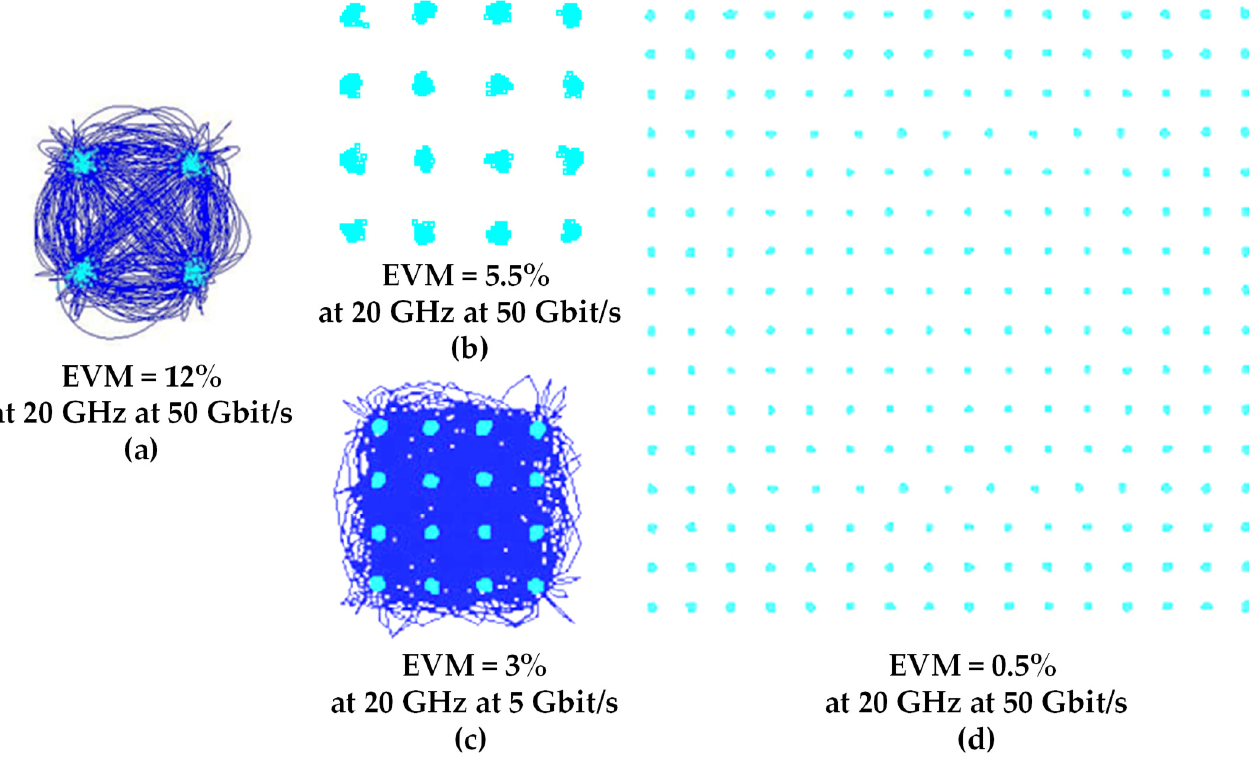
Figure 14. Constellation diagrams of the 4-QAM ( a ), 16-QAM ( b , c ), and 256-QAM ( d ) “AND” signals at the outbound port of the applied SOA-MZI.